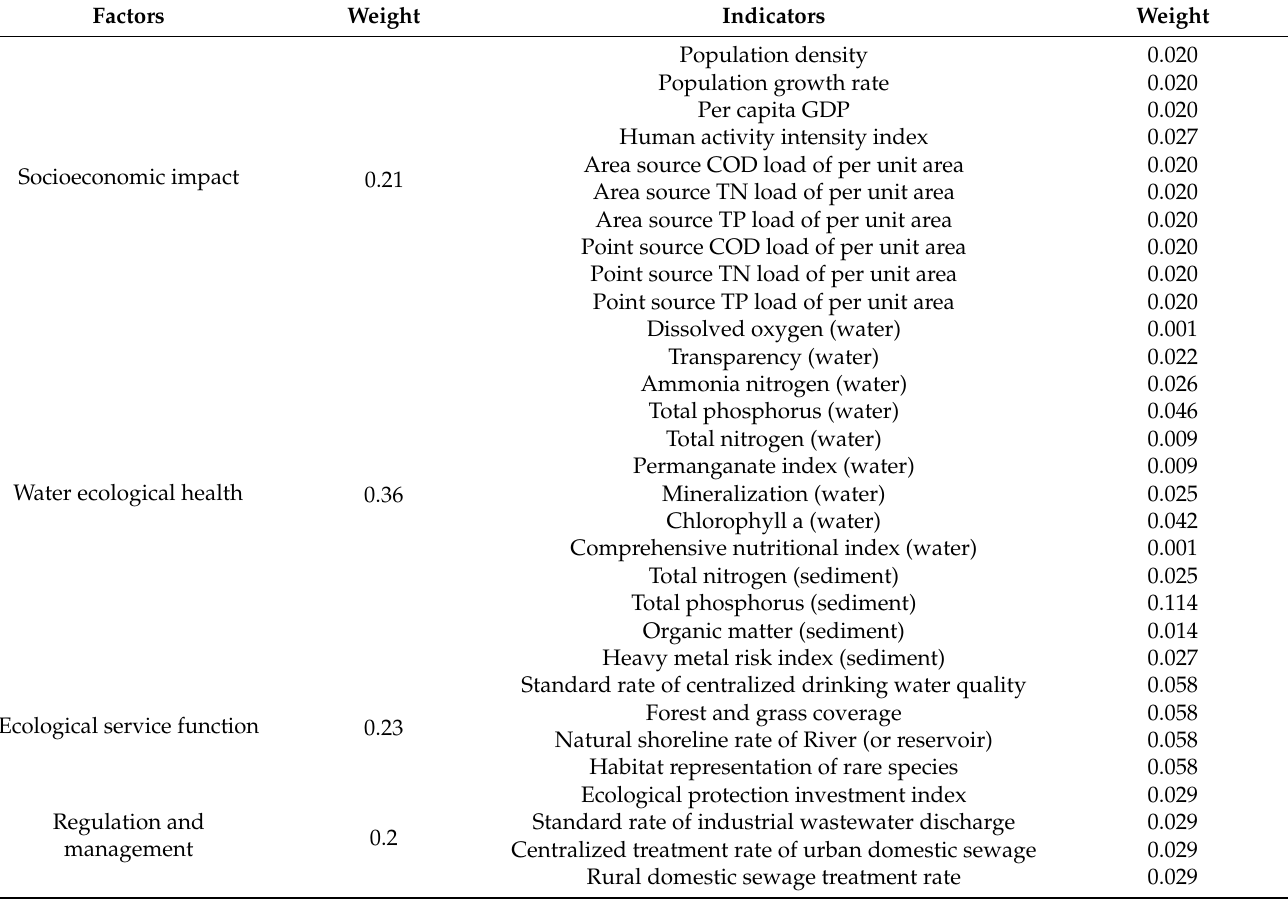
Table A3. Weight of each factor and indicator.